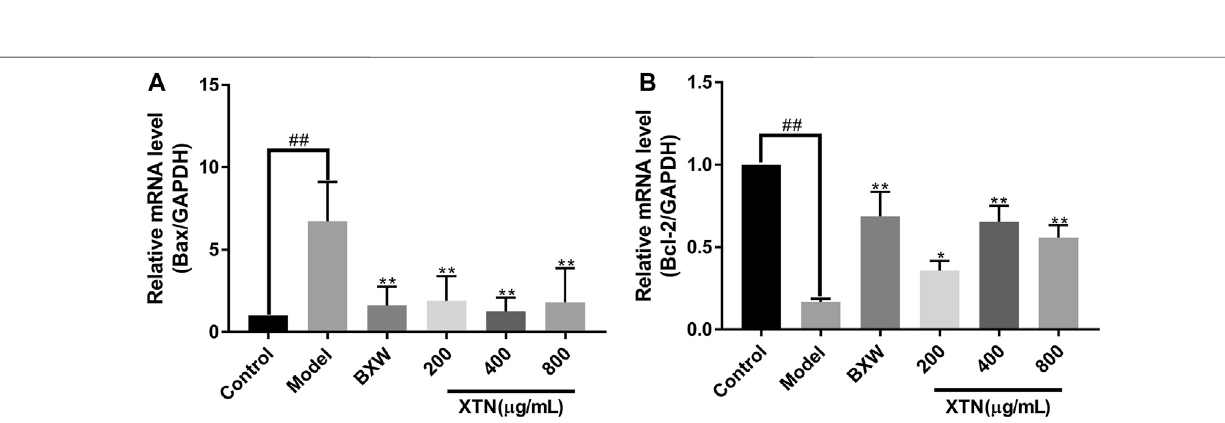
Frontiers in Pharmacology |